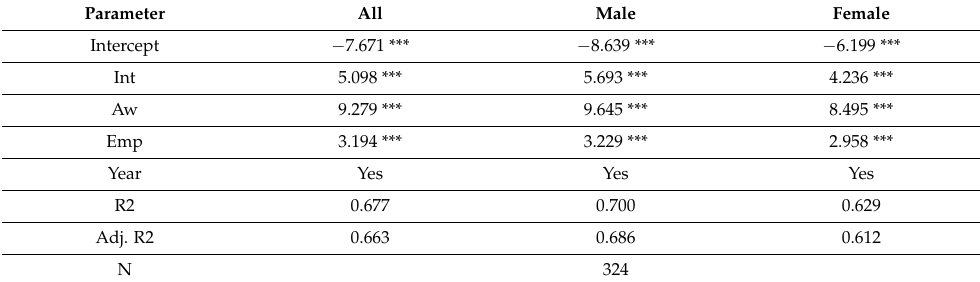
Table 4. Parameter estimates for teleworking